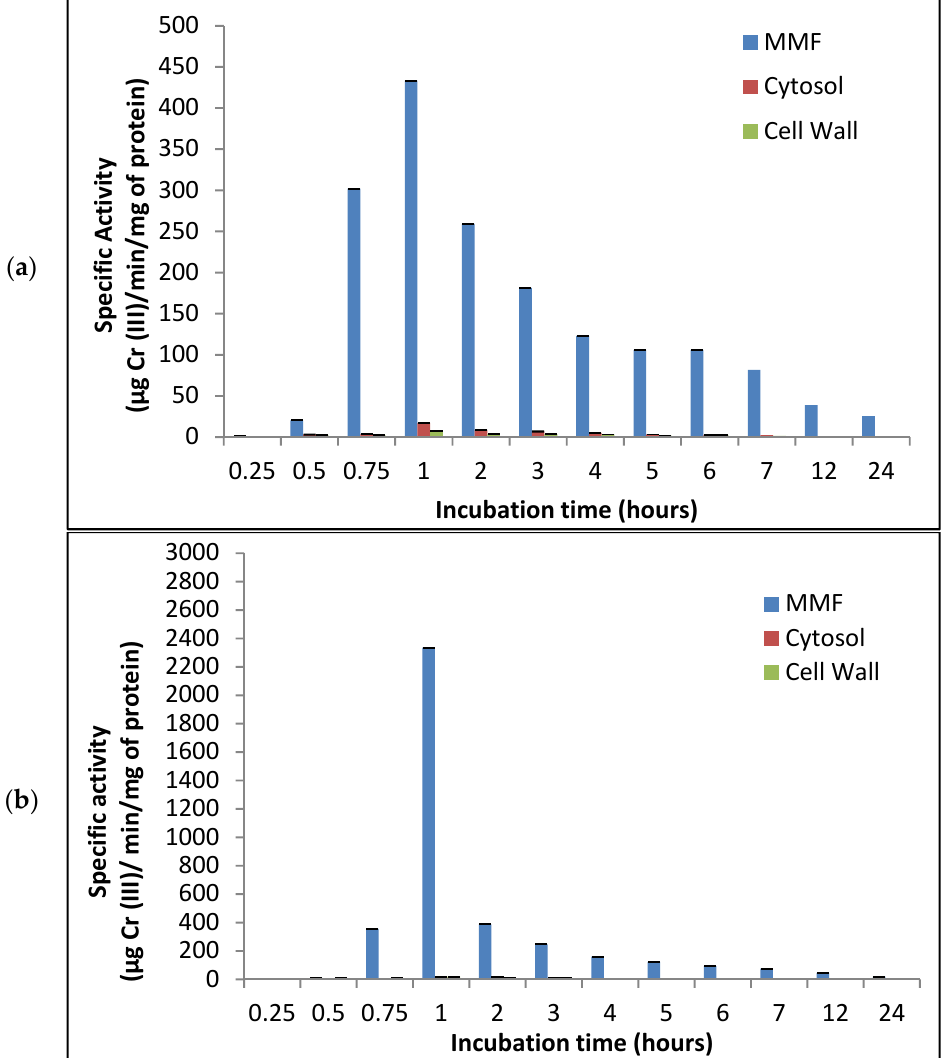
Figure 1. Reductant activity in different cell fractions of the fungus P. lilacinum at different incubation times. 28 °C, pH 7.0, 100 rpm. ( a ) Without NADH+ as electron donor, ( b ) With NADH+ 10 mM.